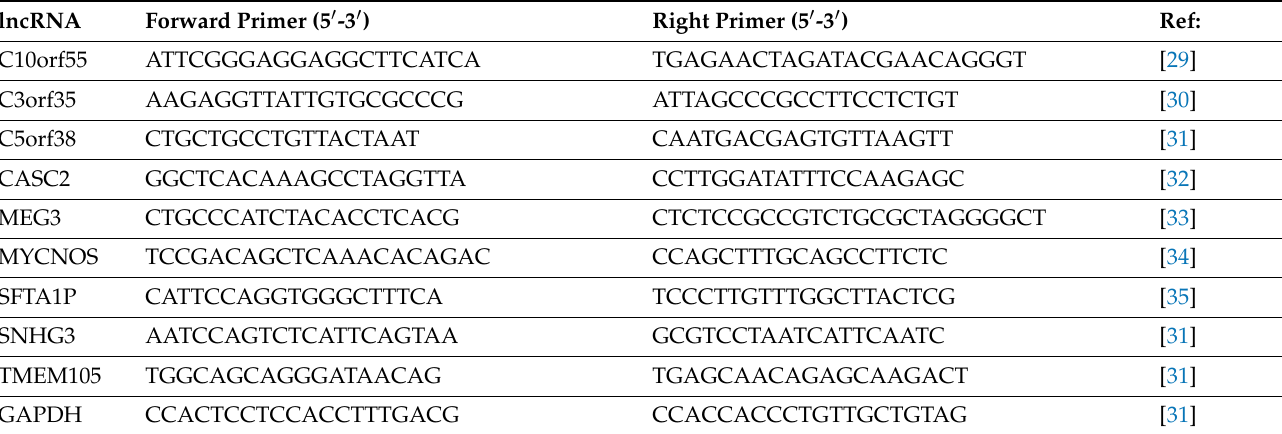
Table 1. Primer sequences used in the qRT-PCR reaction.